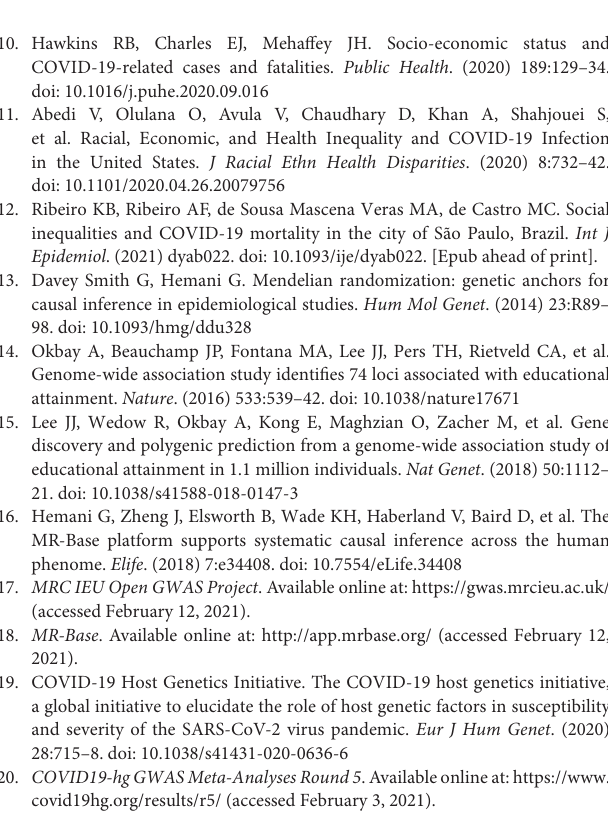
Supplementary Figure 1 | Forrest plots. Each black point represents the causal estimate of each SNP on the risk of COVID-19 severity per increase in years of schooling, and red points show the combined causal estimates using IVW and MR-Egger regression methods with horizontal lines denoting 95% confidence intervals. Supplementary Figure 2 | Funnel plots. Each black point representing an SNP is plotted in relation to the estimate of years of schooling on the risk of COVID-19 severity (x-axis) and the inverse of standard error (y-axis). Vertical lines show the combined causal estimates using IVW (light blue) and MR-Egger regression (blue) methods. Supplementary Figure 3 | Leave-one-out sensitivity analysis. Each black point represents the combined causal estimates on the risk of COVID-19 severity per increase in years of schooling using IVW methods with horizontal lines denoting 95% confidence intervals after removing the corresponding SNP from the analysis. Supplementary Table 1 | Contributing studies of the exposure GWAS data and the outcome GWAS data. Supplementary Table 2 | The characteristics of all the SNPs included in our